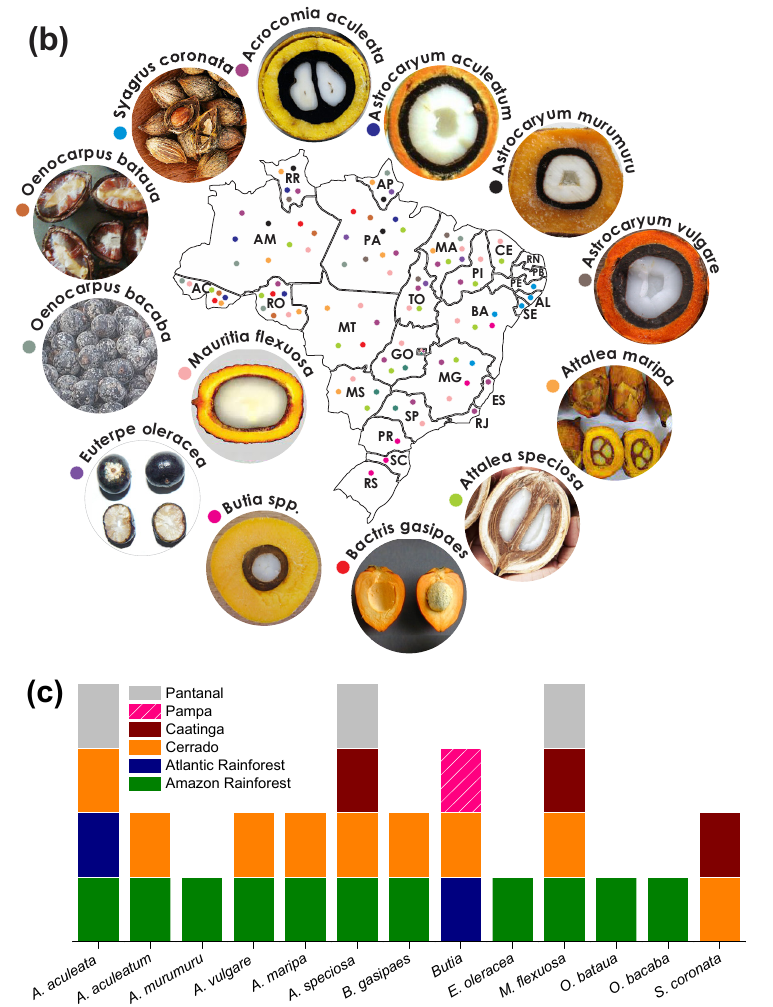
Figure 6. Occurrence of 13 Arecaceae palm trees worldwide ( a ) and their fruits with the corresponding presence in Brazilian states ( b ) and Brazilian biomes ( c ). Adapted from Refs. [8,26]. Fruit images are royalty-free, adapted from Brazilian Agricultural Research Corporation— EMBRAPA (http://embrapa.br/imagens/, accessed on 2 June 2022) and Wikimedia Commons (http://commons.wikimedia.org/, accessed on 2 June 2022).